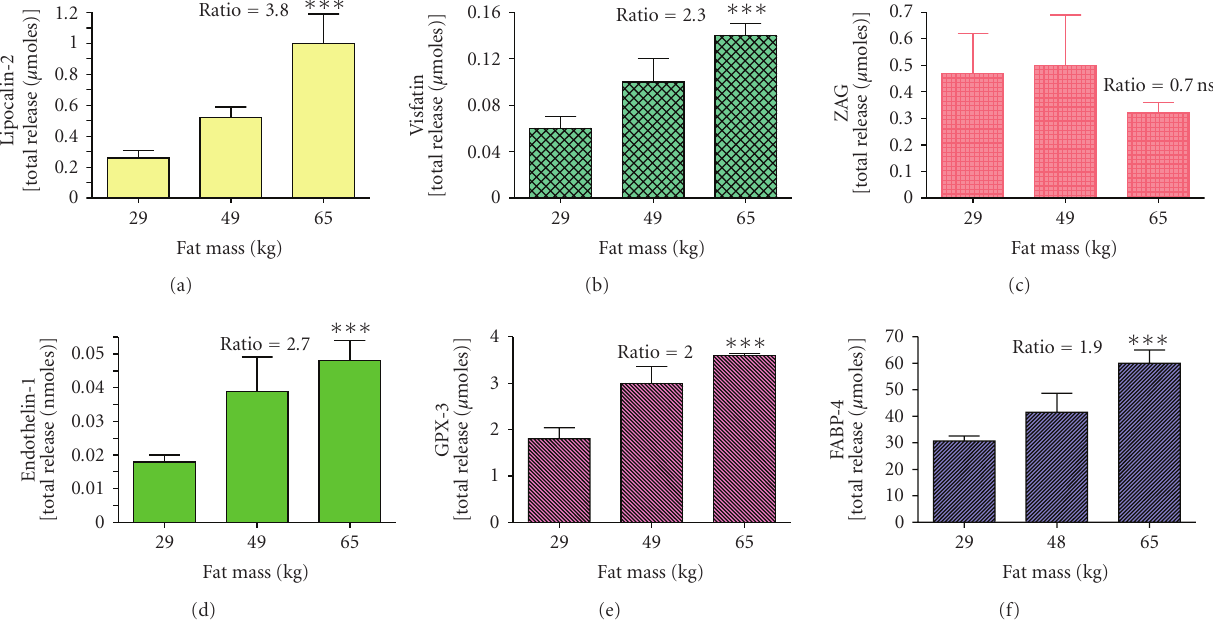
Figure 3: The e ff ect of obesity on total release of 6 adipokines by explants of adipose tissue from obese women. The data are from the report by Fain et al. [42] for release of 6 adipokines by adipose tissue from 22 women divided into tertiles. The lowest tertile was composed of 7 women with total fat masses of 18 to 40kg with a mean of 29kg. The middle tertile was composed of fat from 8 women with total fat masses ranging from 41 to 52kg with a mean of 49kg. The highest tertile was fat from 7 women with fat masses ranging from 56 to 75 kg (mean of 65kg). The ratio of total release by the highest tertile as compared to the lowest tertile is shown and all ratios were significant with a P < . 001 except for zinc α 2 glycoprotein [ZAG] release that was not statistically significant ( P > .